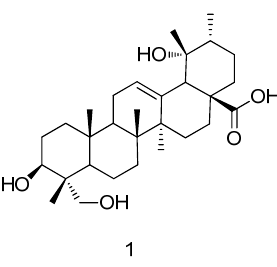
Figure 1. Structure of rotundic acid ( RA